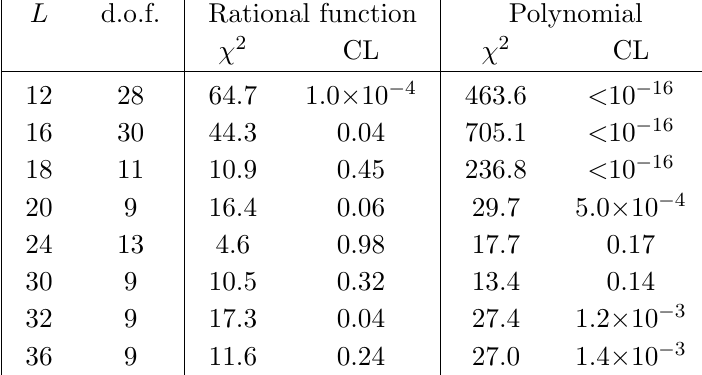
g 2 ( (cid:12) F ), with (cid:28) opt = 0 : 08 e c =0 : 25